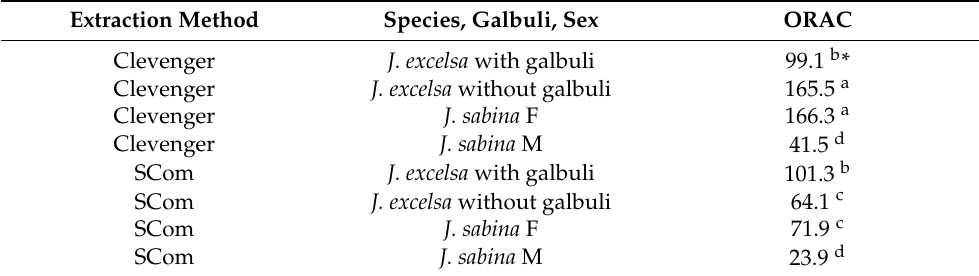
Table 11. Mean ORAC ( µ mol Trolox®g − 1 ) obtained from the eight combinations of the extraction method and species/galbuli/sex.